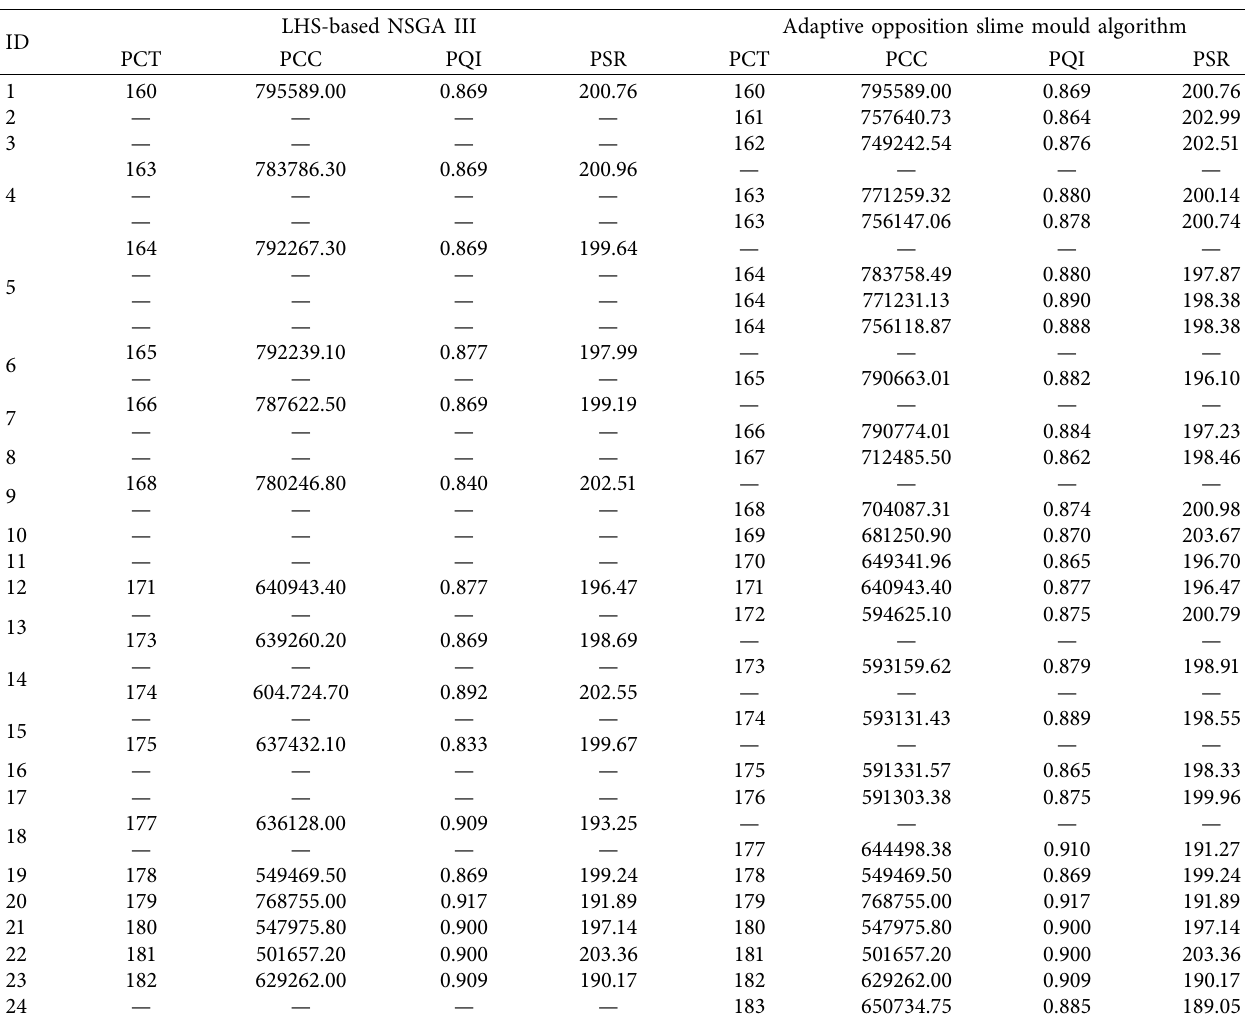
Figure 25: Value path plot of AOSMA for case 2. Table 7: LHS-based NSGA III and AOSMA result comparison for case